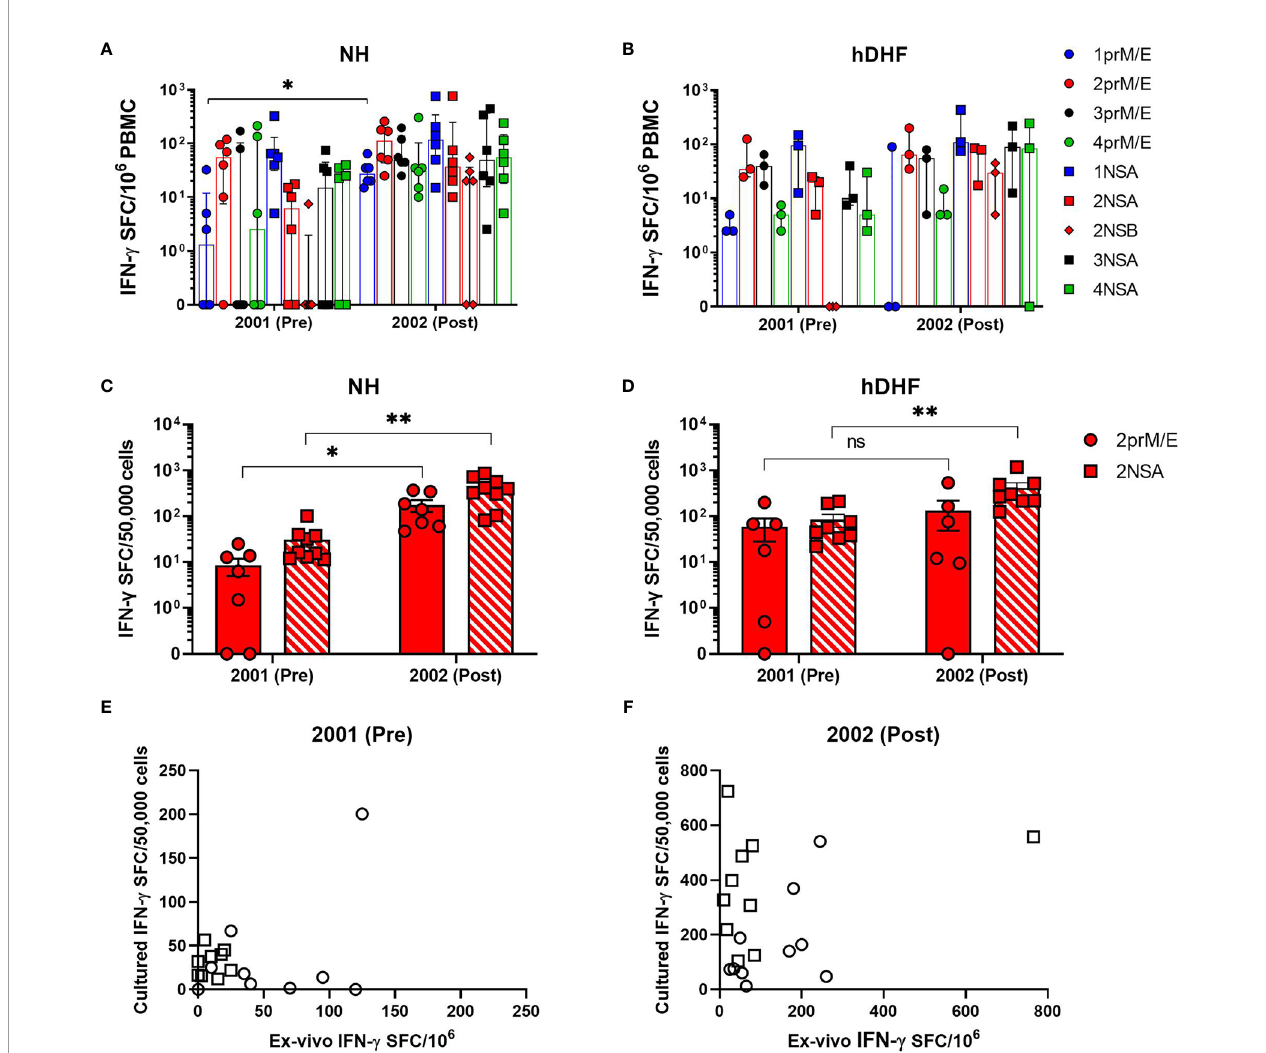
FIGURE 1 | Comparison of ex-vivo and cultured IFN- g ELISPOT. DENV-speci fi c IFN- g spot-forming cells (SFC) were determined by ex-vivo (A, B) and cultured ELISPOT (C, D) in PBMCs collected before (pre) and after (post) secondary DENV-2 infection in NH (A, C) and hDHF (B, D) subjects. PBMC were stimulated with peptide pools corresponding to prM and E proteins (prM/E), NS1, NS3, and NS5 proteins (NSA), or C, NS2A/B, and NS4A/B proteins (NSB) of the indicated DENV serotype. Bars represent median + interquartile range. Graphs (E, F) depict correlation analysis between frequencies of DENV-speci fi c T cells detected by ex-vivo and cultured ELISPOT- 2001 2prM/E (r=0.07531, p= 0.8525); 2001 2NSA (r= 0.2343, p= 0.5397); 2002 2prM/E (r=0.2121, p= 0.5603); 2002 2NSA (r= 0.1152, p= 0.7589). Frequency of cytokine-producing cells in PBMC from each subject represented by circles (response to 2prM/E) and square (response to 2NSA). Statistics were calculated by the non-parametric Wilcoxon matched-pairs signed-rank test ( A – D , comparing responses to the same peptide pool between 2001 and 2002) and two-tailed Spearman ’ s correlation test (E, F) . *p < 0.05, **p < 0.01, ns, not signi fi